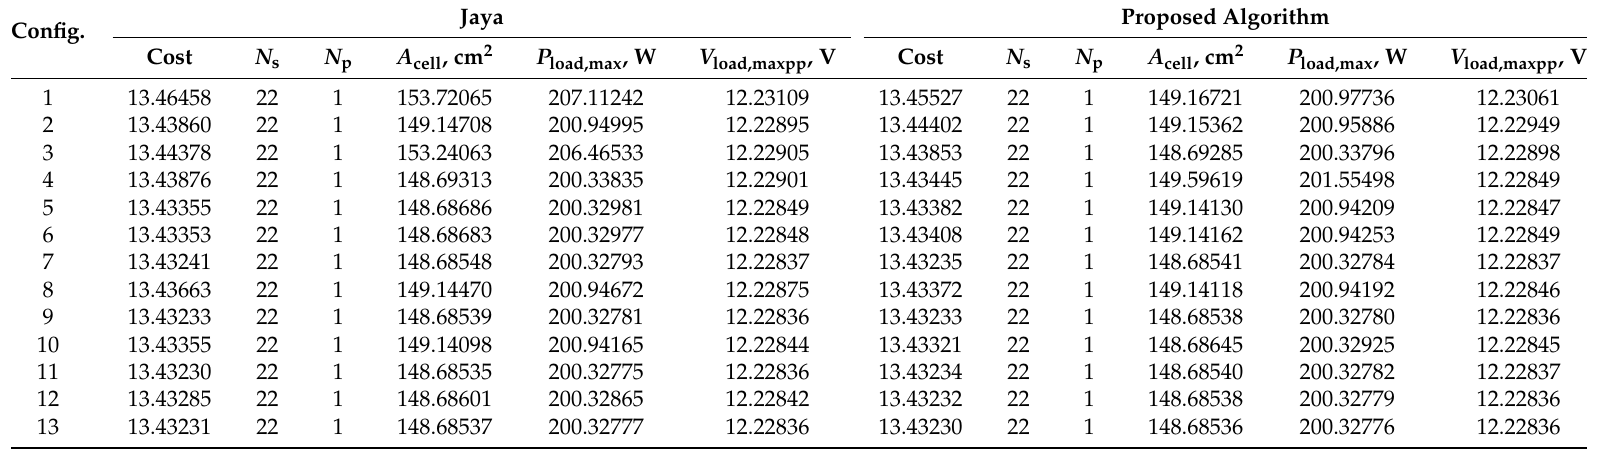
Table 13. Best of best-of-run solutions (stack